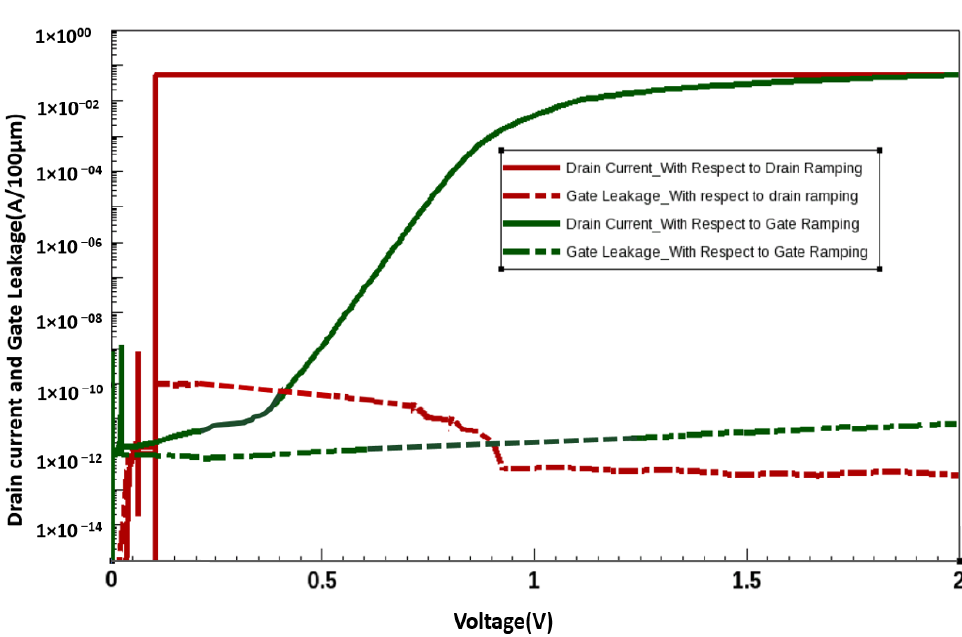
Figure 6. IV Curve with gate ramping = 2V for AlGaN/GaN HEMT.